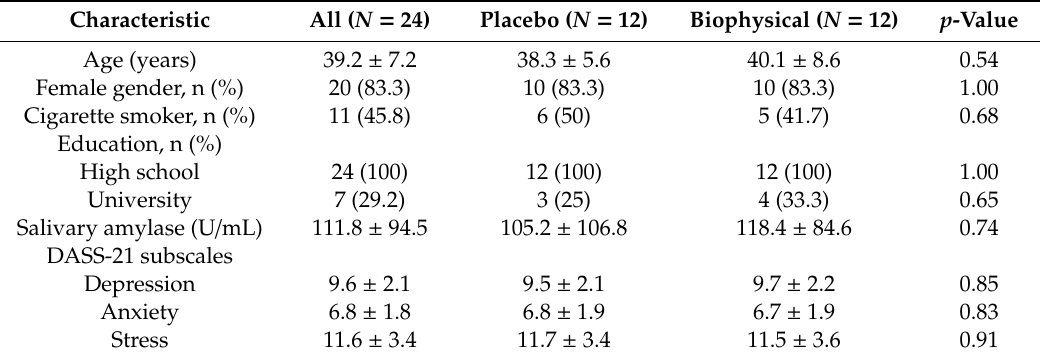
Table 1. Baseline clinical characteristics of control and biophysical